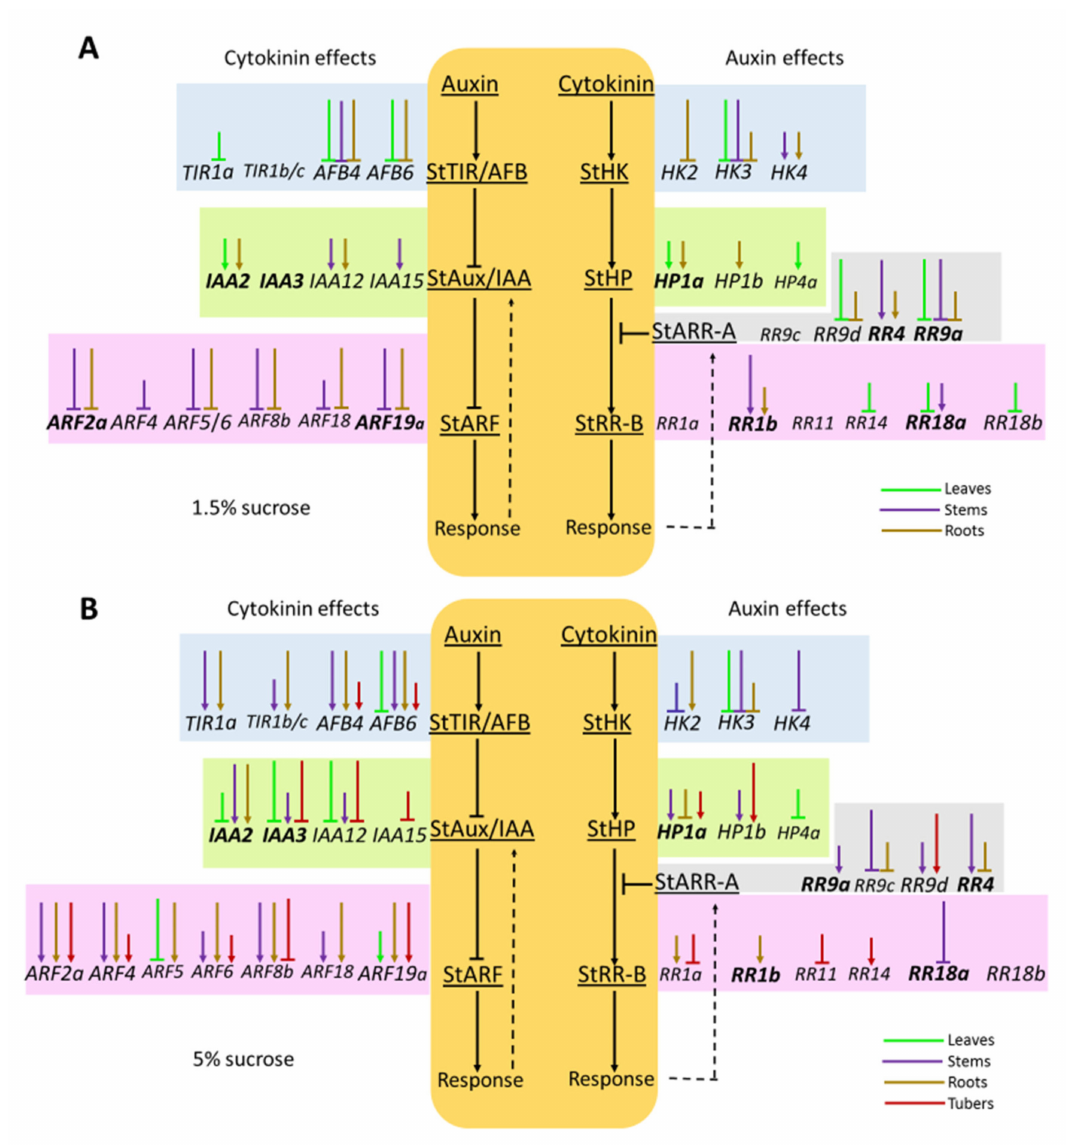
Figure 10. The scheme summarizing all putative links which can be implicated in auxin-CK crosstalk in potato at the signaling level. The schematic auxin- (on the left) and CK (on the right) signaling pathways reside in the center, and genes encoding defined protein family are grouped in a row at the cognate protein level. Colored arrows show potential interactions: pointed or blunted arrows indicate activation or inhibition, respectively. Arrows corresponding to each potato organ are marked with a distinct color. Long arrows indicate pronounced effects (fold changes >2), short arrows indicate apparent trends (fold changes >1.5 but <2). Data on plants grown on media with 1.5% ( A ) sucrose or 5% ( B ) sucrose are given